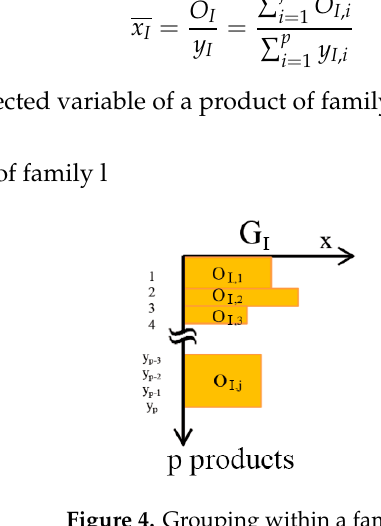
Figure 4. Grouping within a family.